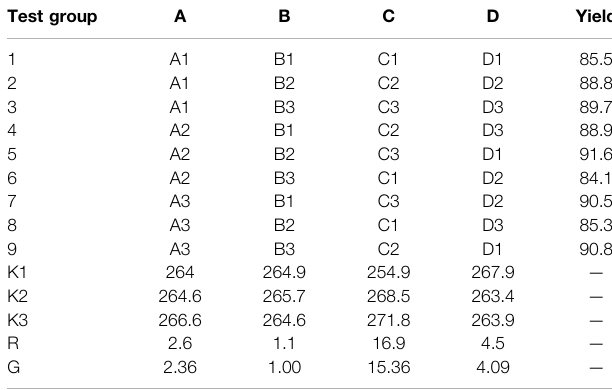
TABLE 2A | 2-FSMN orthogonal experiment table. Factor\level